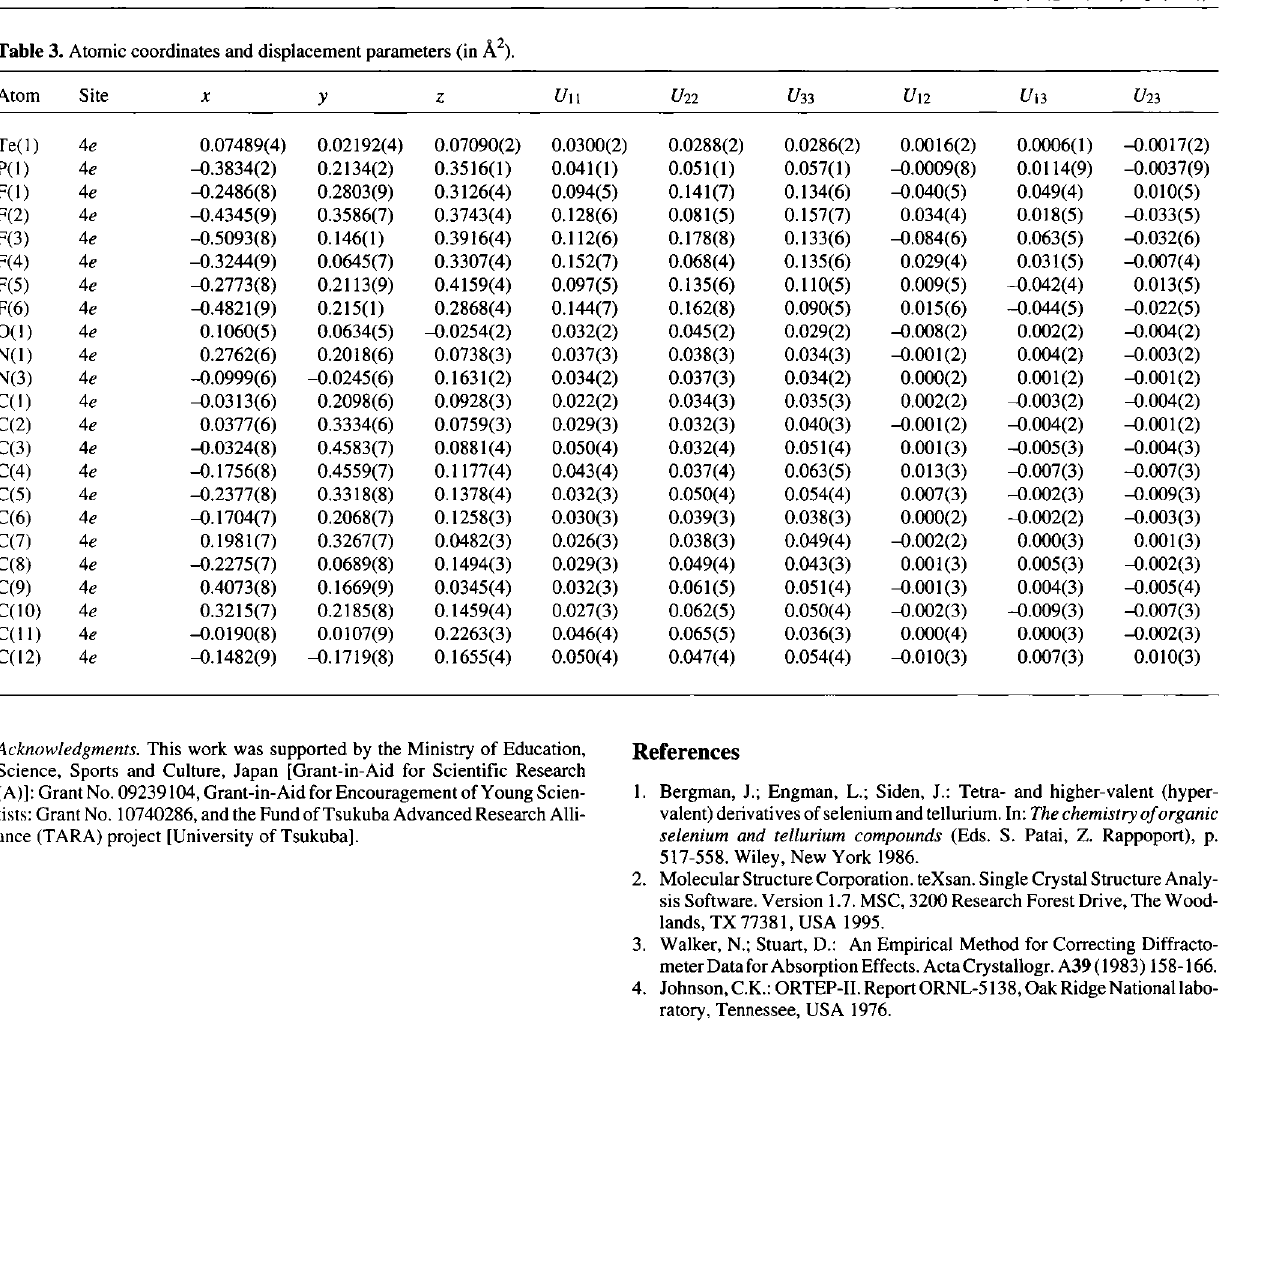
Table 3. Atomic coordinates and displacement parameters (in Ä 2 ).